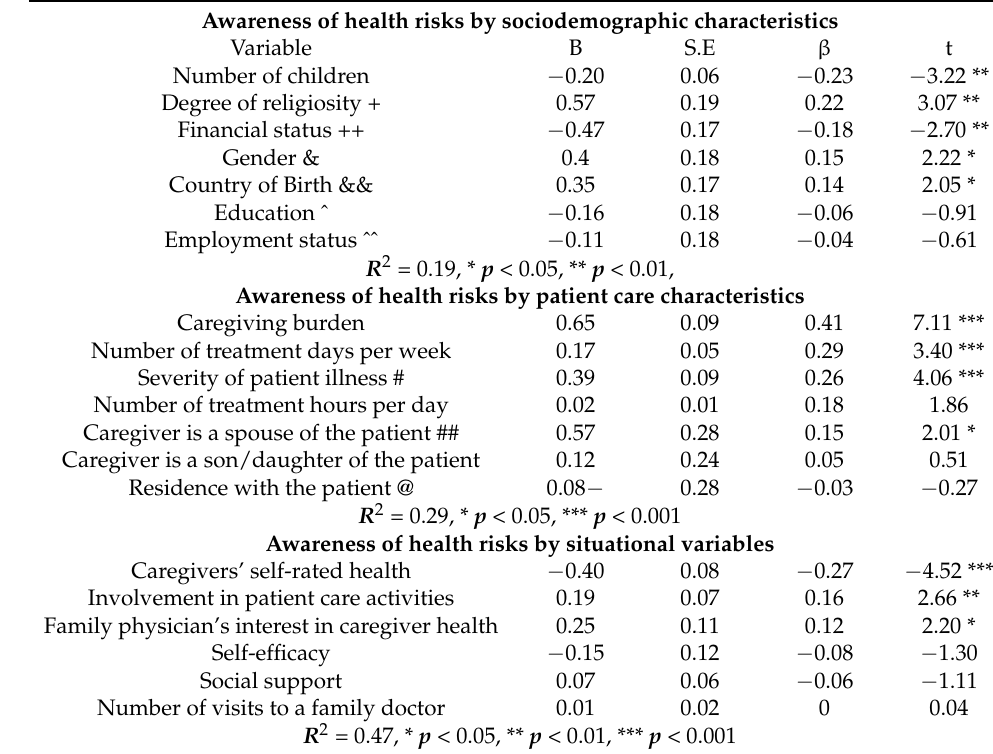
Table 3. Results of a multiple linear regression analysis to explain the level of caregivers’ awareness of health risks by sociodemographic characteristics, caregiving characteristics, and situational variables ( n =